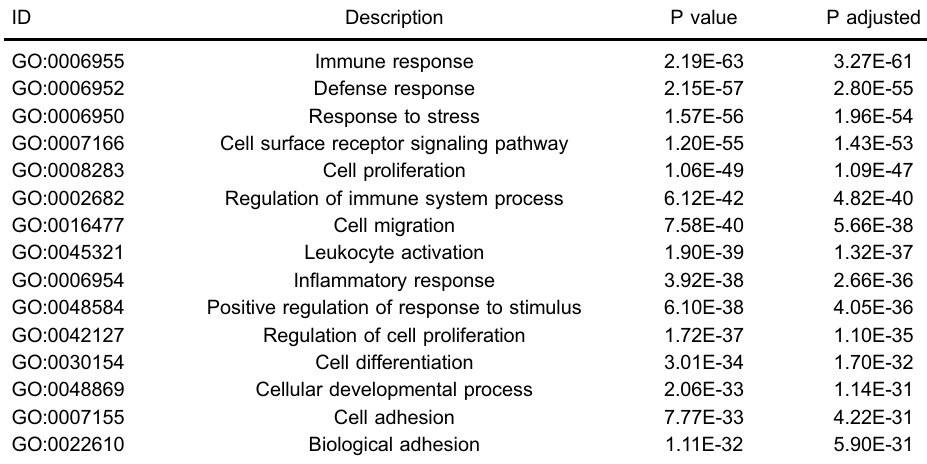
Figure 2. Heatmap of sample clustering based on differentially expressed factors. Horizontal axis indicates samples; vertical axis indicates differentially expressed factors. Table 1. Top 15 gene ontology functions enriched by differently expressed genes. ID